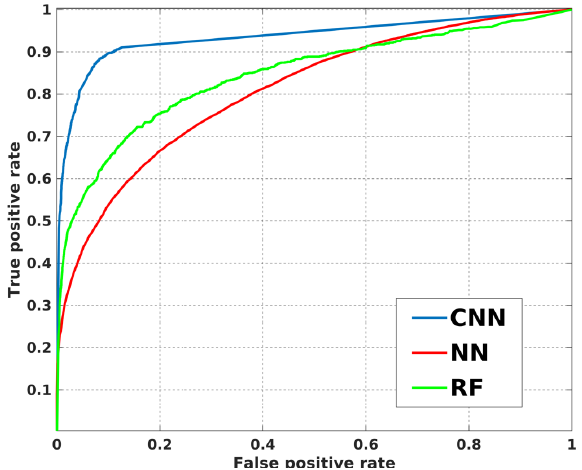
Figure 5. ROC curves for different classifiers with same set of